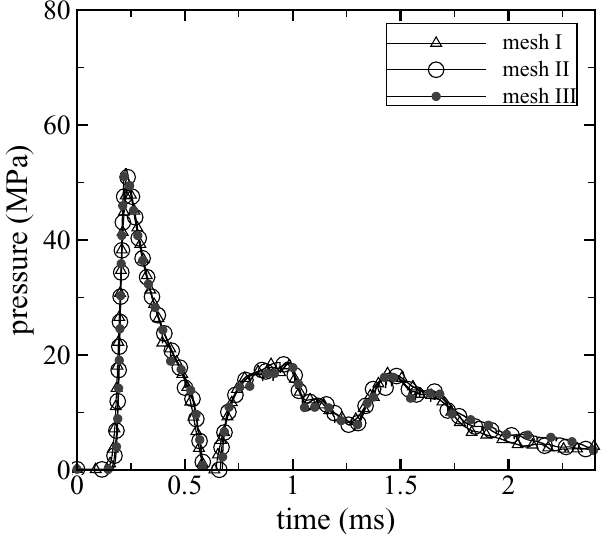
Fig. 3. Grid convergence study of the wet face pressure at the